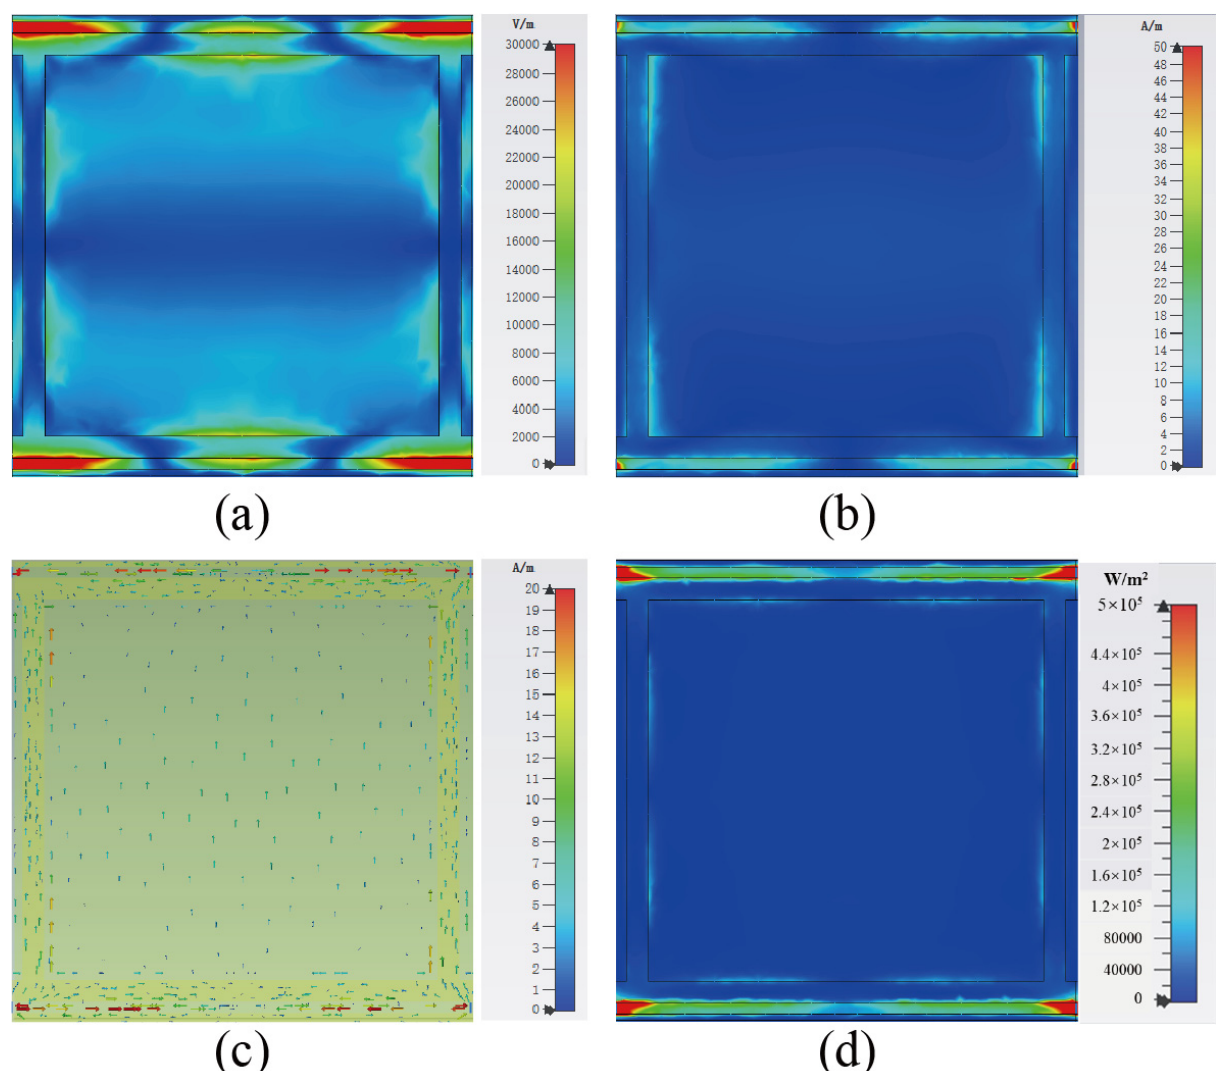
Figure 6. Simulations of ( a ) electric field magnitude, ( b ) magnetic field magnitude, ( c ) surface current distribution, and ( d ) power flow diagram distribution of the metasurface array unit cell at 12.6 GHz with incident plane wave irradiation along the − z -direction.